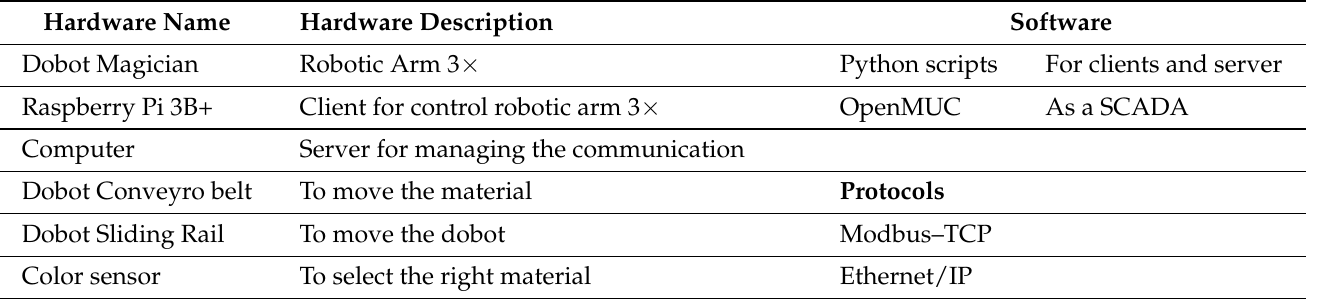
Table 9. Components of industrial production loop